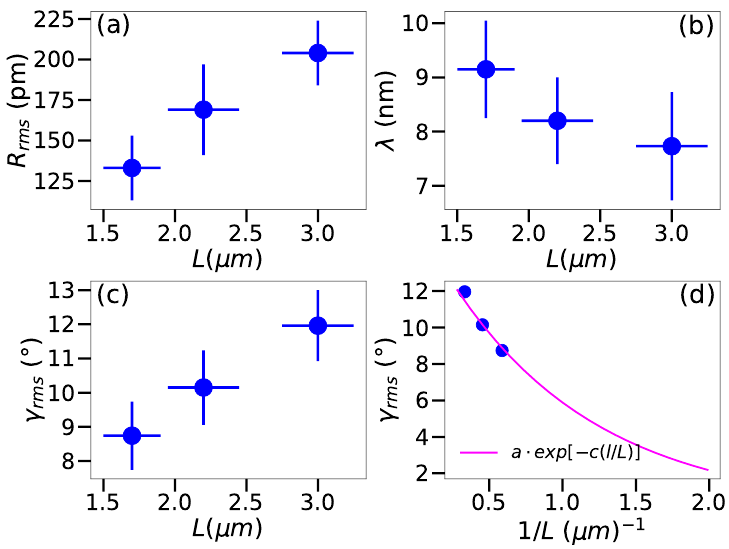
Figure 2. Corrugations in CVD-grown graphene with different sizes of suspended area. ( a – c ) Cor- rugation parameters for different sizes of the free-standing graphene area. The error bars correspond to the standard deviation of the data and the uncertainty in the size of the free-standing area arising from its ellipticity. ( d ) Root-mean-square inclination ( γ rms ) as a function of the inverse size of the freestanding area, with a fit to a · exp [ − c ( l / L )] , where a and c are fit parameters and l the electron coherence